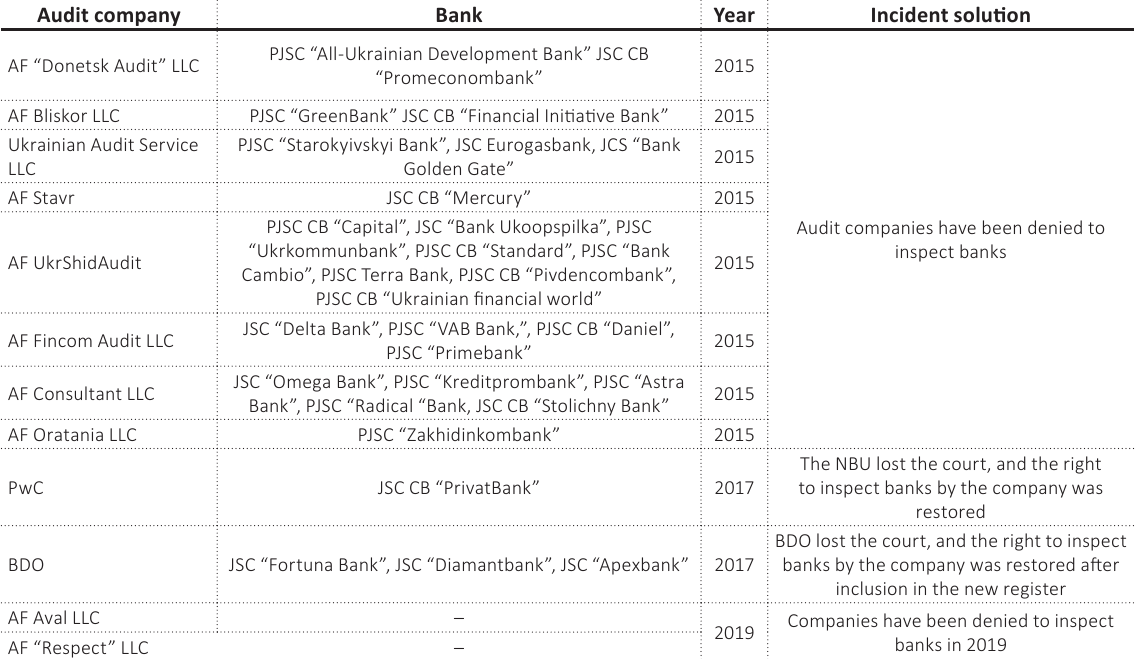
Source: Compiled by the authors according to NBU